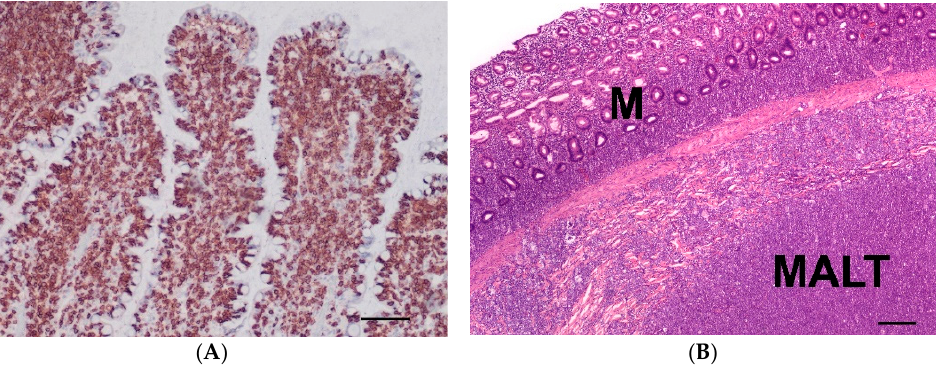
Figure 3. ( A ) Immunohistochemistry of a T-cell lymphoma (small intestine) with intense CD3 expression of neoplastic lymphocytes (brown) of an 11-year-old male castrated mix; (bar = 100 µm). ( B ) Lymphoma in the large intestine affecting the mucosa (M) and mucosa-associated lymphatic-tissue (MALT) of a 5-year-old male Bulldog; (HE, bar = 200 µm).